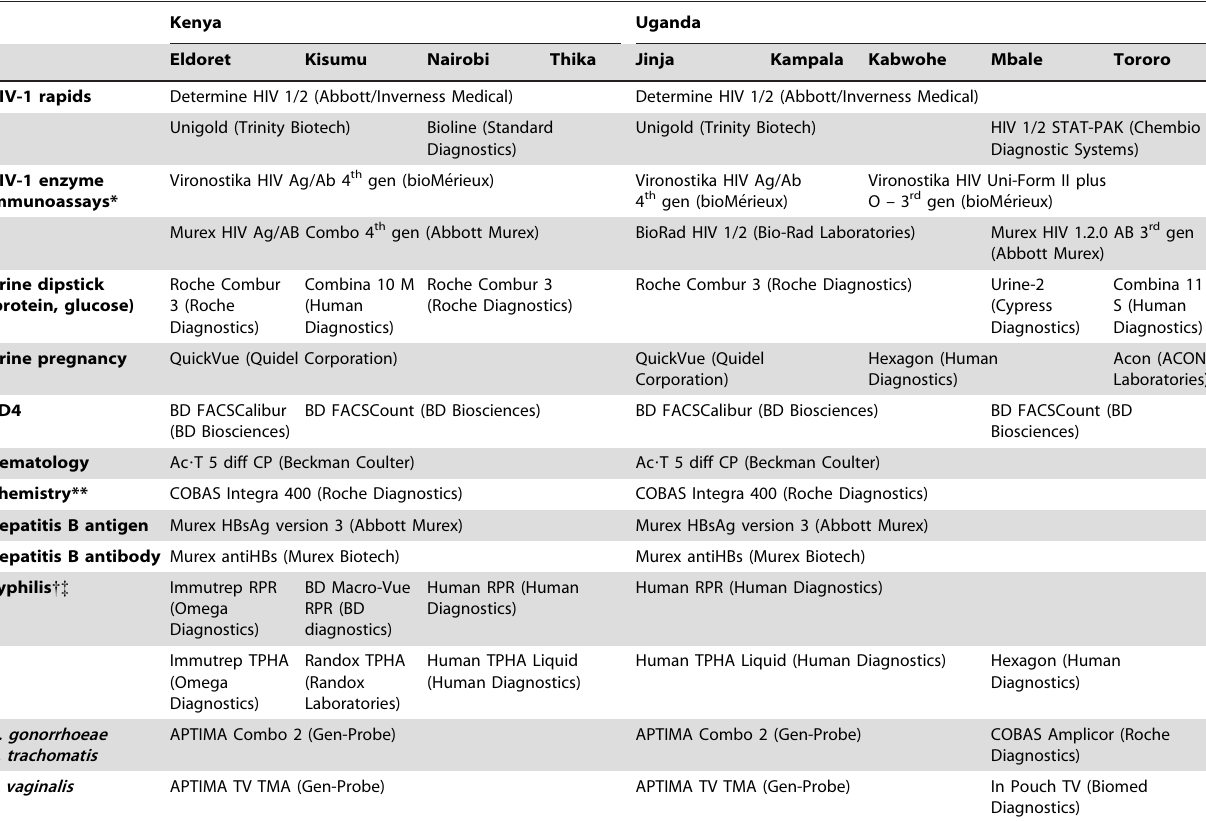
Table 2. Study Site Laboratory